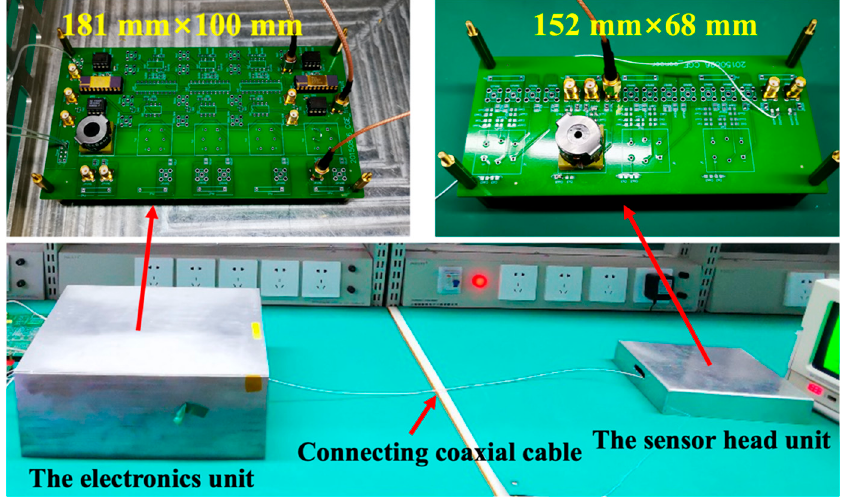
Figure 5. The prototype circuit of the capacitive position sensor in our laboratory.